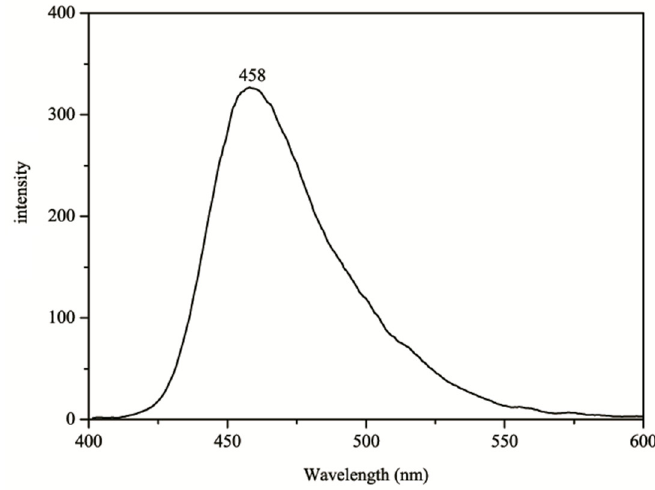
Figure 4. The luminescent spectrum of the Cd(II) coordination polymer.